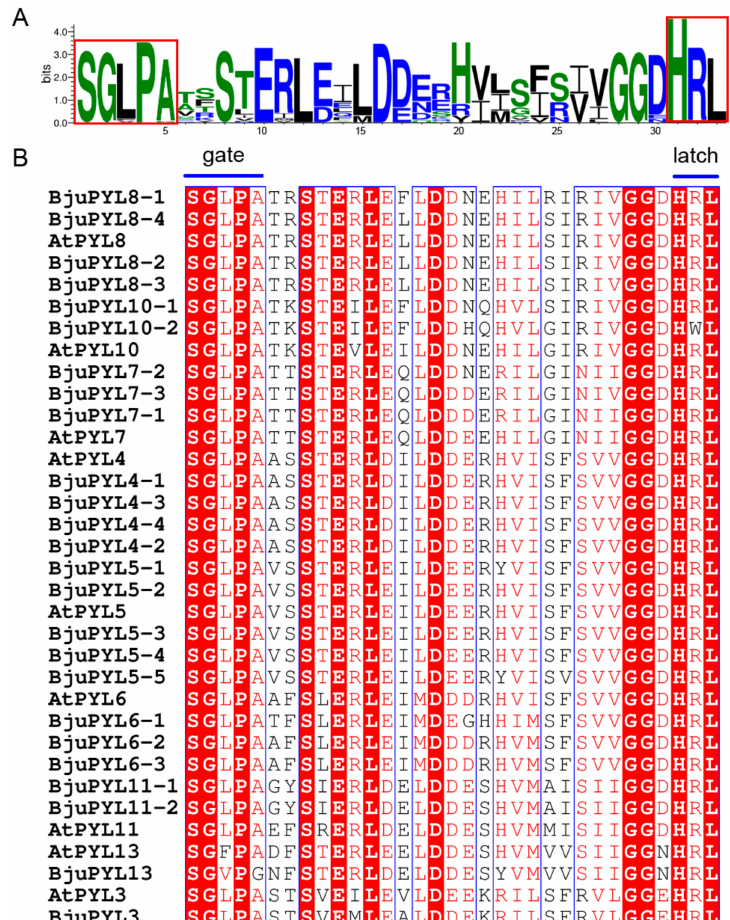
Figure 3. The alignment of PYL proteins and protein domain prediction. ( A ) The PYLs protein sequences were aligned by WebLogo online software, and the gate and latch residues are boxed. ( B ) The PYLs protein sequences were aligned by ESPript online software. Conserved residues are highlighted, and the gate and latch residues are